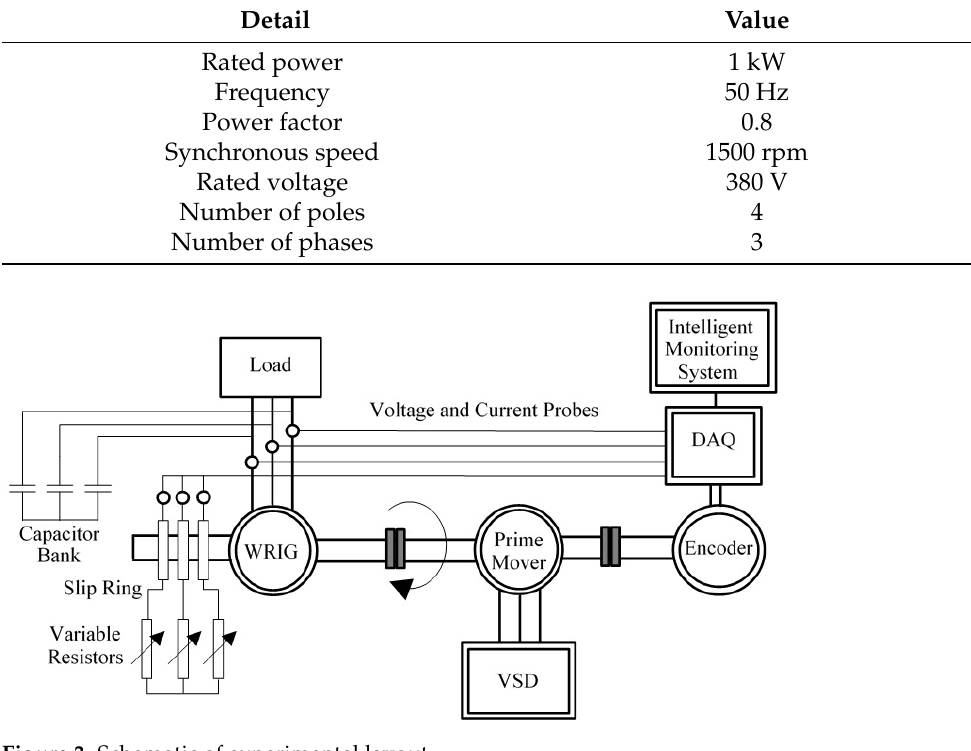
Figure 3. Schematic of experimental